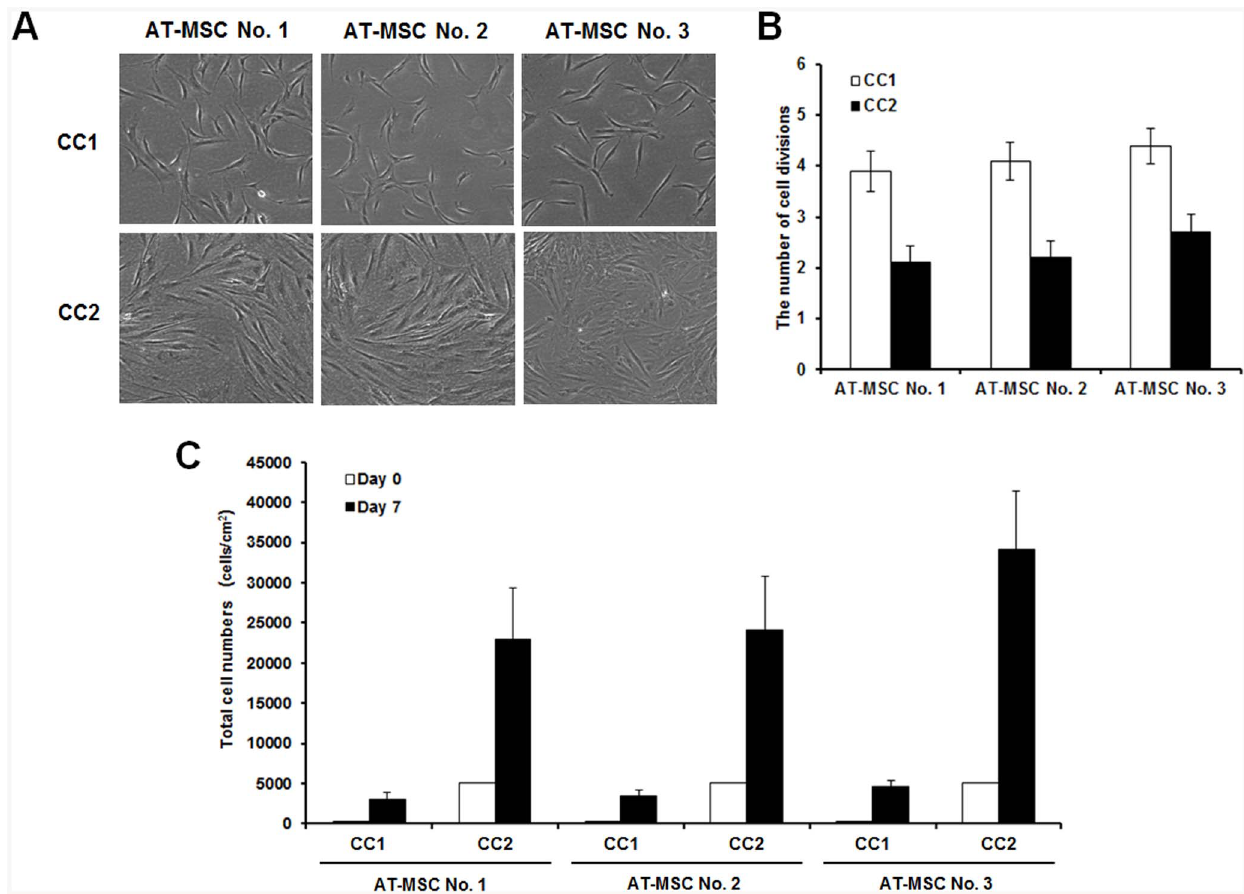
Figure 2. Phase-contrast micrograph and cell density of AT-MSCs from three different donors in CC1 or CC2. ( A ) Morphological appearance of AT-MSC donors 7 days after plating at 200 cells/cm 2 (CC1) or 5,000 cells/cm 2 (CC2). All cells exhibited a spindle shaped or fibroblastic morphology. ( B ) The number of cell divisions and ( C ) total cell numbers at the time of harvest of MSCs cultured under different conditions. Data are the mean 6 SD from three separate experiments.